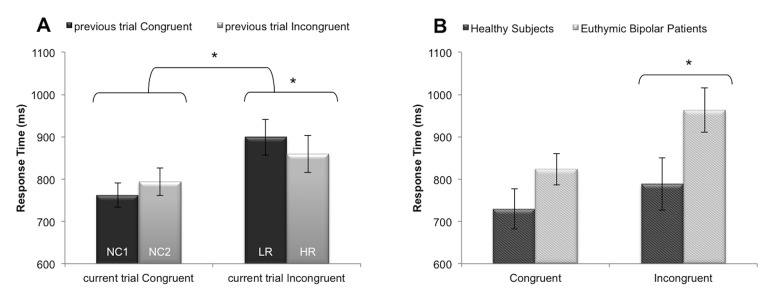
Behavioral performances during word-face emotional Stroop.Panel A: Illustration of behavioral dissociation between conflict monitoring and conflict resolution. The graph shows the mean response time ± SE according to the congruency of the current trial and the congruency of the previous trial. Panel B: Illustration of the increase emotional interference in euthymic bipolar patients. The graph shows the mean response time ± SE according to the group and the congruency of the current trial. *p<0.05. Abbreviations: LR: Low conflict resolution; HR: High conflict resolution; NC: No conflict.